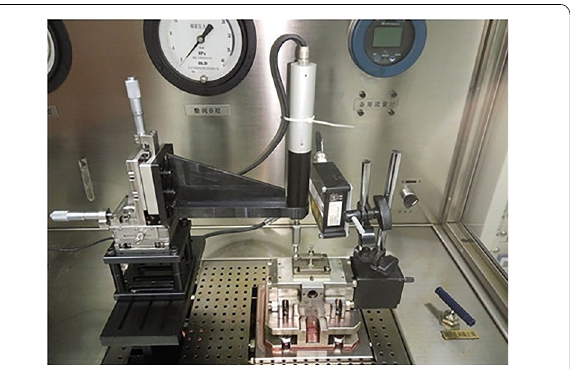
Figure 24 Experimental device